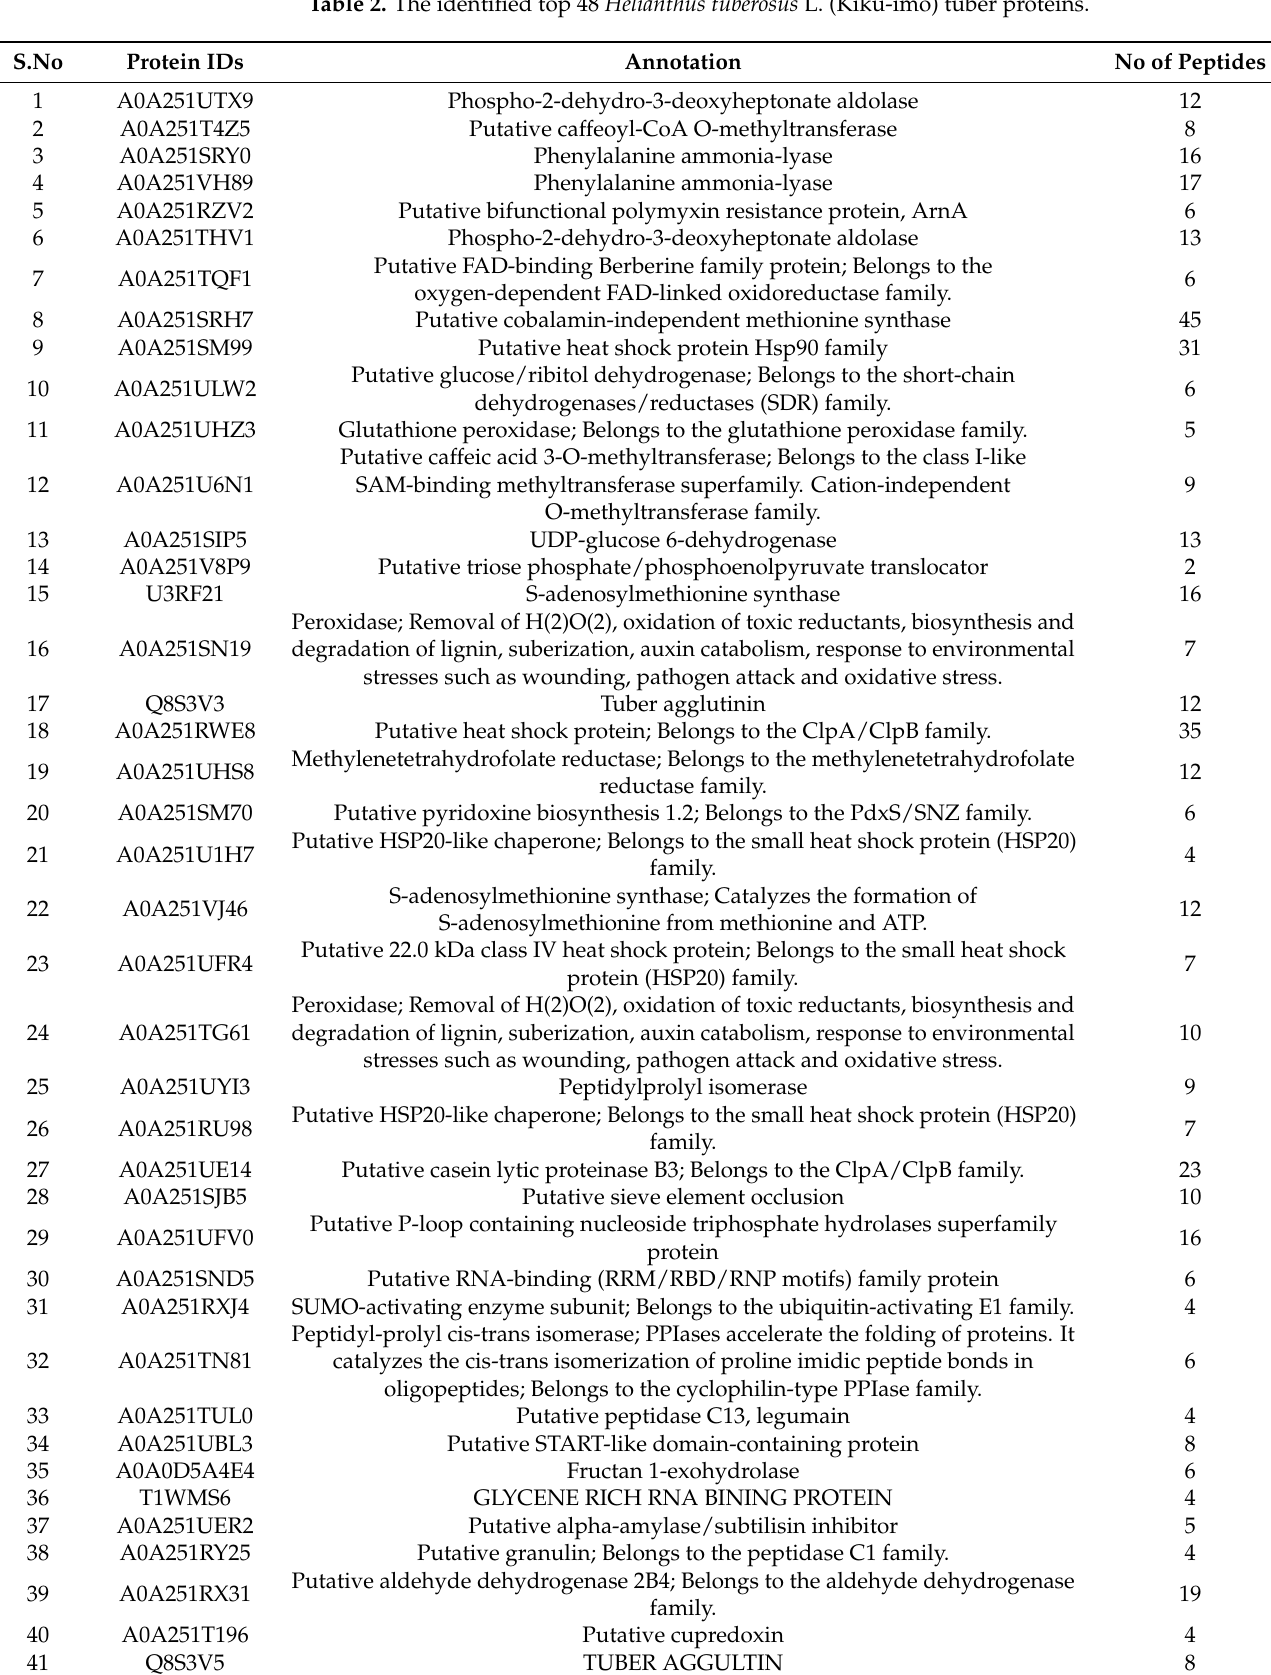
Table 2. The identified top 48 Helianthus tuberosus L. (Kiku-imo) tuber